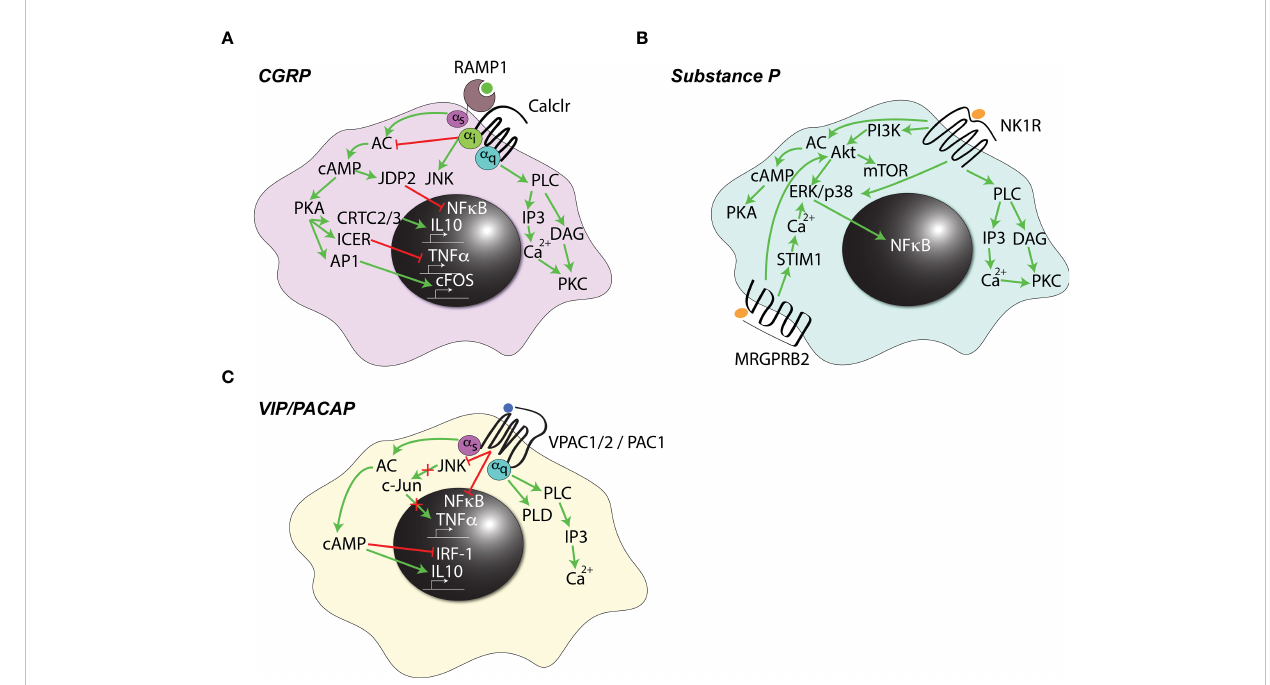
FIGURE 2 Signaling pathways downstream of neuropeptide receptors. Known signaling pathways initiated by (A) calcitonin gene-related peptide (CGRP), (B) Substance P, or (C) vasoactive intestinal peptide (VIP) and pituitary adenylate cyclase-activating polypeptide (PACAP) signaling in immune cells are summarized. Green arrows indicate activation, red blunt-ended arrows indicate